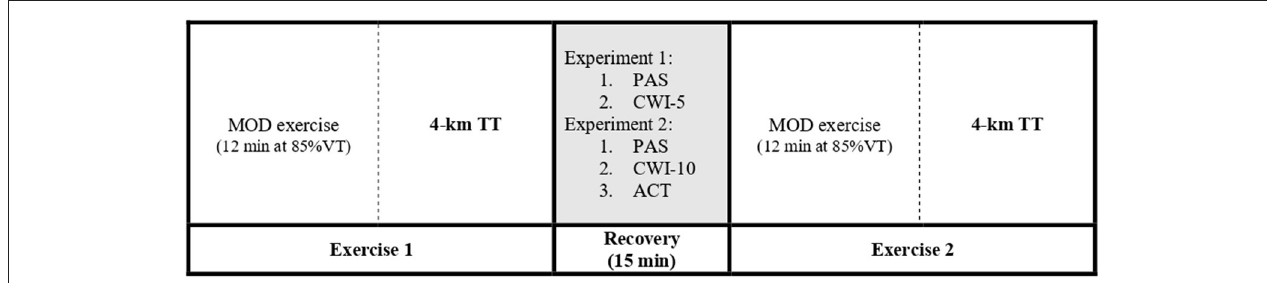
FIGURE 1 | Timeline of experimental protocol. In Experiment 1 the recovery treatments included passive recovery (PAS) and 5min cold water immersion (CWI-5); in Experiment 2 , passive recovery (PAS), 10min cold water immersion (CWI-10), and active recovery (ACT). VT, first ventilatory threshold; MOD, moderate-intensity cycling exercise; TT, time